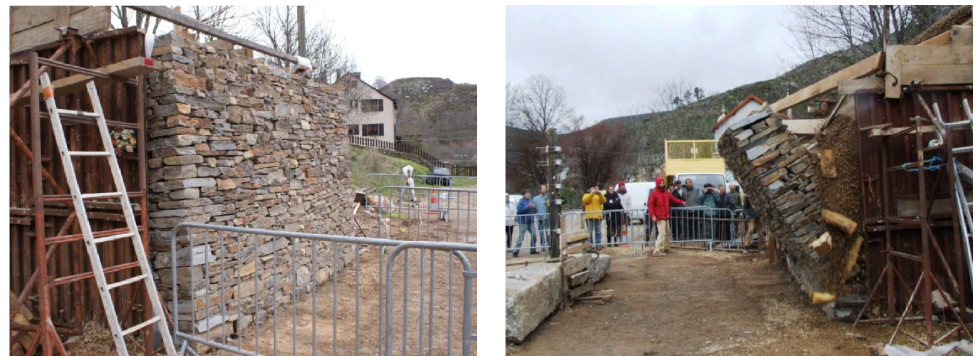
Figure 8. Picture of the “C3s” DSRWs tested by A.S. Colas: initial and collapse configurations are shown